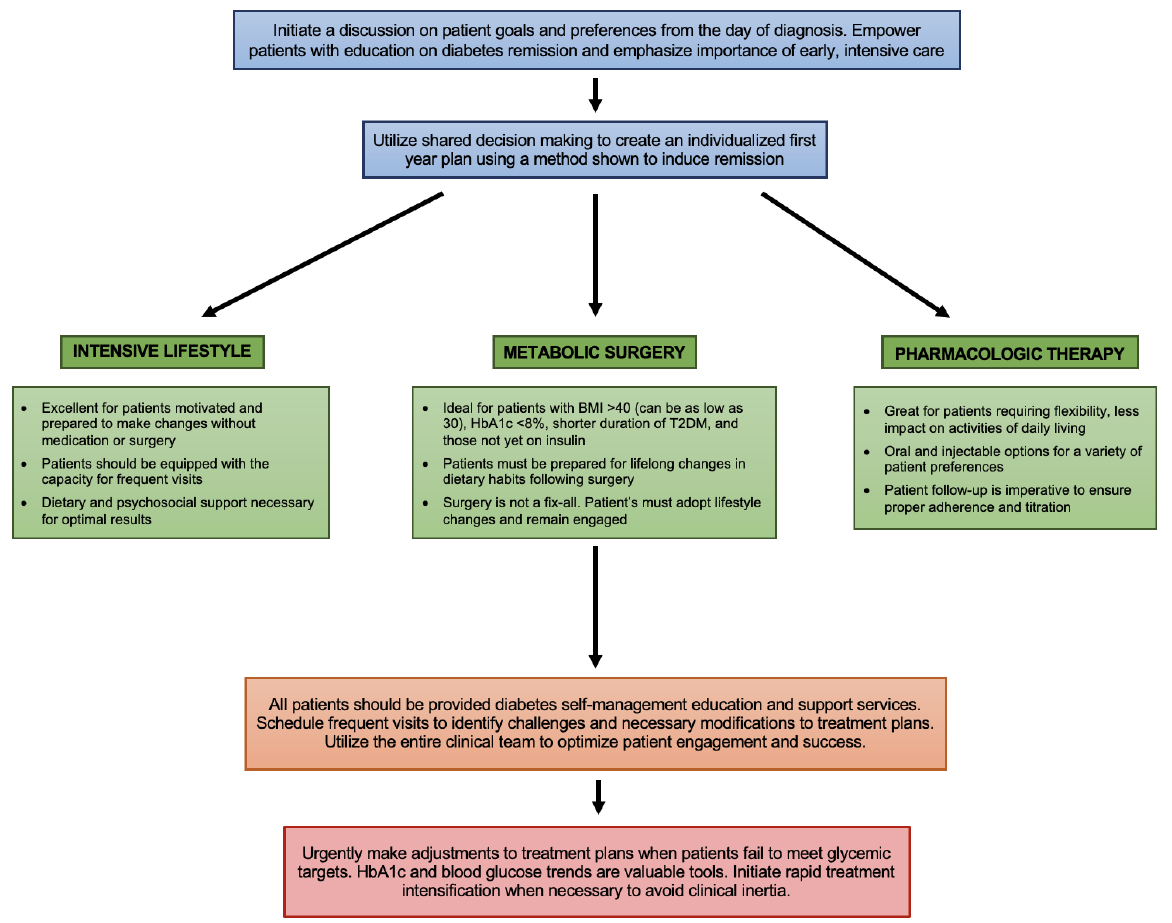
Figure 5. Creating a first-year plan to achieve remission. A flowchart describing methods shown to induce remission and practical application of a first-year plan. Intensive lifestyle refers to DiRECT protocol and similar intensive lifestyle modification programs. Metabolic surgery refers methods including Roux-en-Y gastric bypass, sleeve gastrectomy, and laparoscopic adjustable gastric banding. Pharmacologic therapy refers to the combination therapy or intensive insulin therapy.